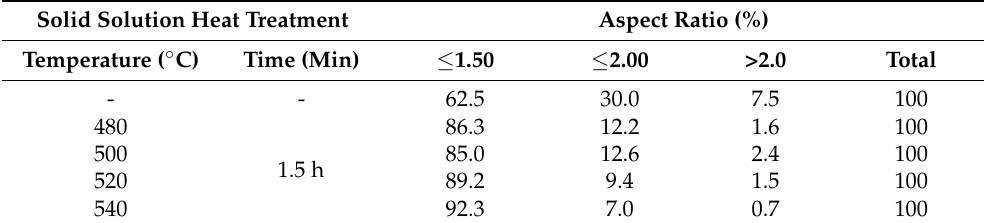
Figure 7. Distribution of the aspect ratios of the Si particles. Table 4. Measurements of the Si particles’ aspect ratios.